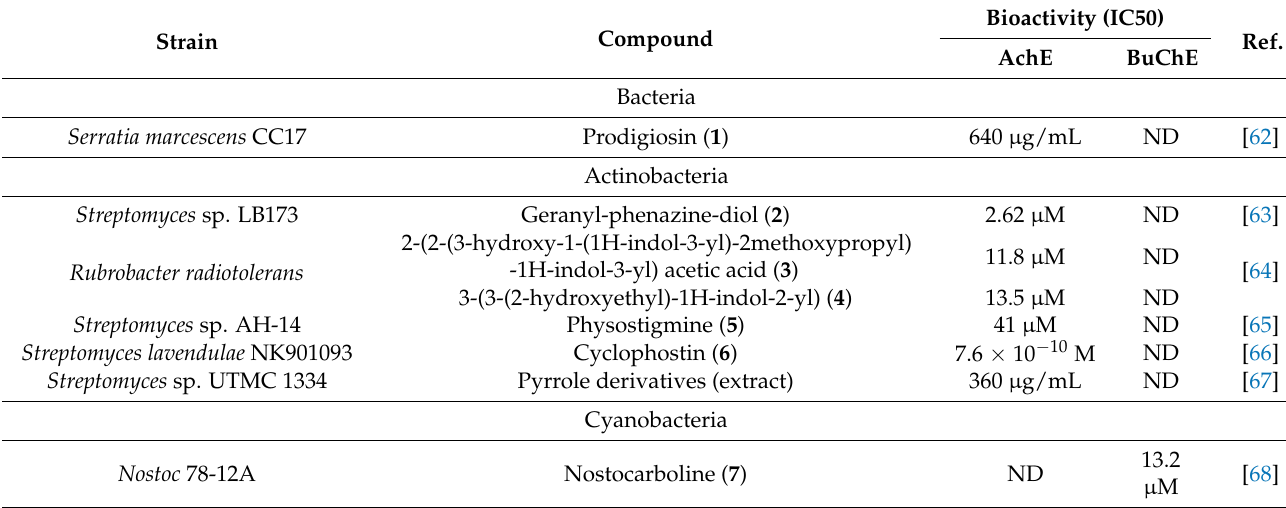
Table 1. The cholinesterase (ChE) inhibitors from